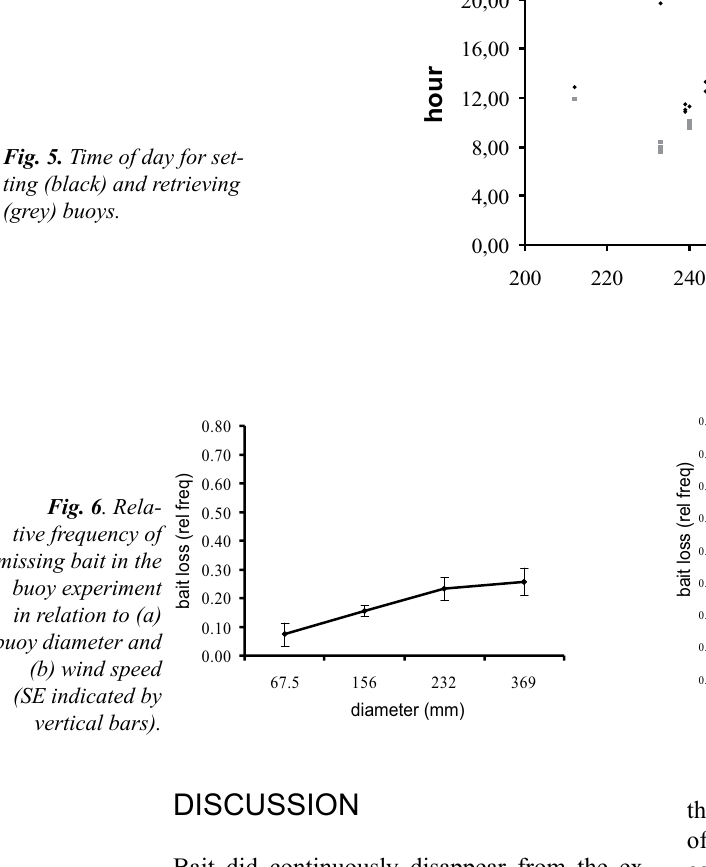
Fig. 5. Time of day for set - ting (black) and retrieving (grey)